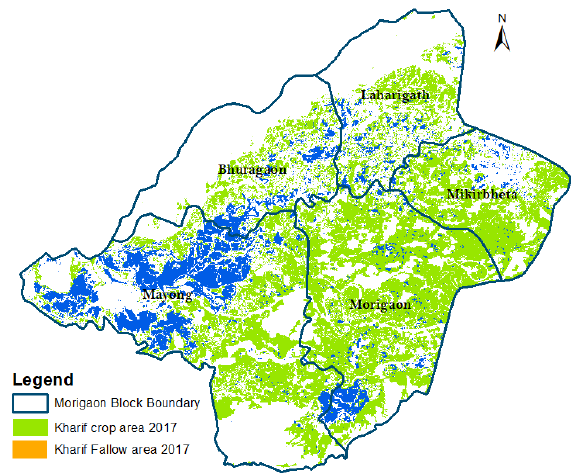
Figure 6. Overlay of Kharif 2017 with Flood layer to demonstrate the flood affected area under agriculture.